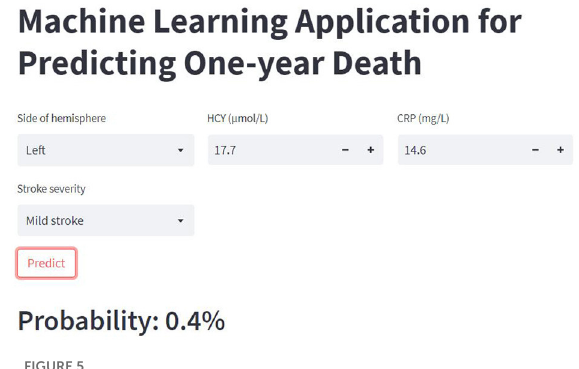
FIGURE5 The web-based calculator for predicting 1-year death in AIS